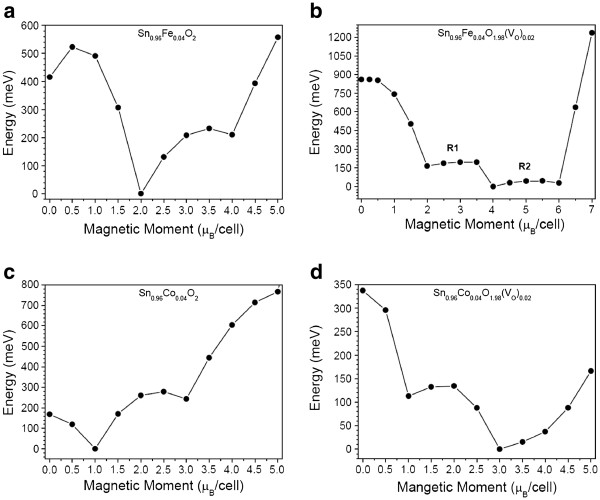
 Total energy vs. magnetic moment per cell. For (a) Sn0.96Fe0.04O2, (b) Sn0.96Fe0.04O1.98(VO)0.02, (c) Sn0.96Co0.04O2, and (d) Sn0.96Co0.04O1.98(VO)0.02. The total energy of the high-spin ground state is set to zero.